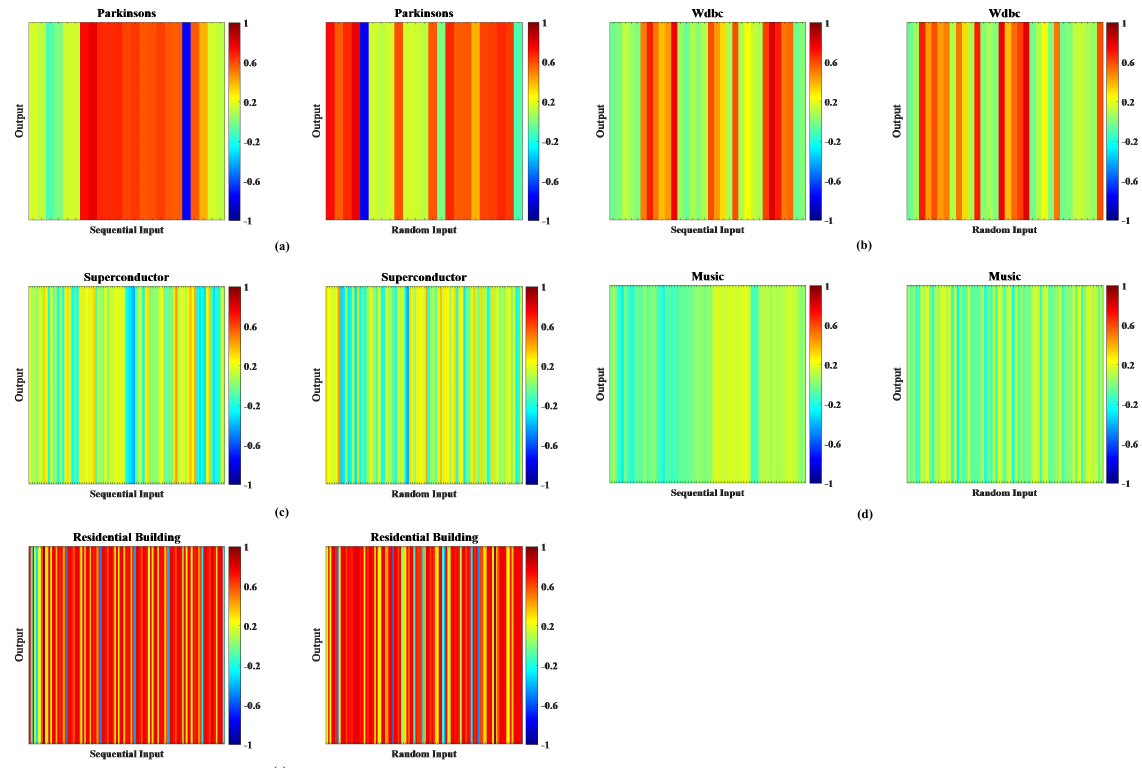
Figure 5. Correlation analysis comparison of sequential inputs with random inputs. ( a ) The random inputs were obtained from Dataset No. 1. ( b ) The random inputs were obtained from Dataset No. 2. ( c ) The random inputs were obtained from Dataset No. 3. ( d ) The random inputs were obtained from Dataset No. 4. ( e ) The random inputs were obtained from Dataset No.